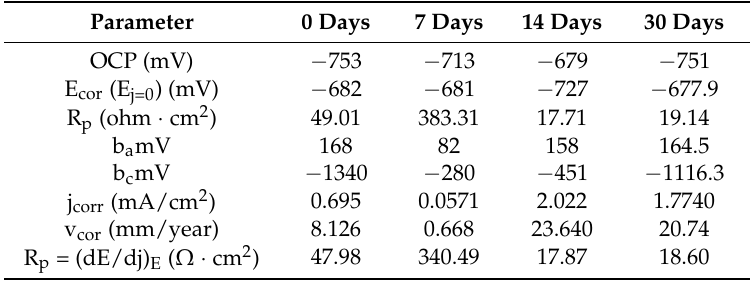
Table 3. Electrochemical corrosion parameters of FeMnSi–MgCa in SBF solution. Parameter 0